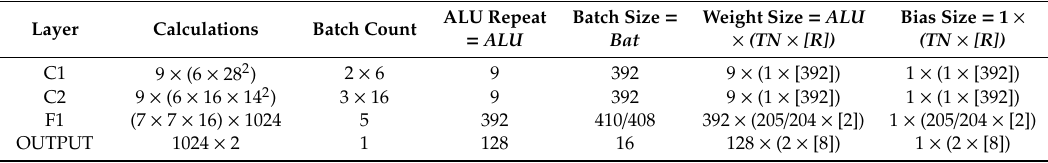
Table 6. Data requirement of each